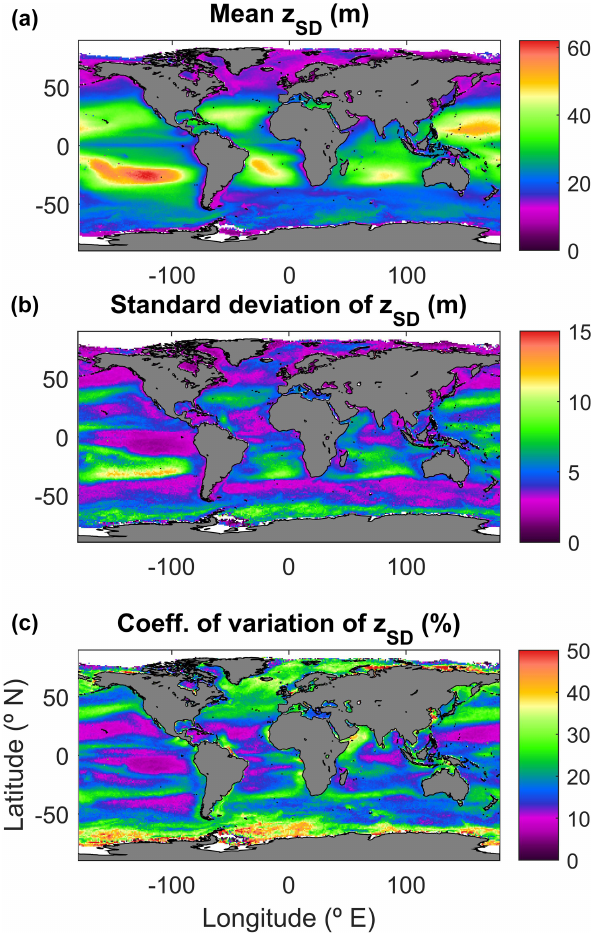
Figure 2. Global maps of the Secchi disk depth ( z SD ) in the period 1997–2018. (a) Series mean. (b) Standard deviation. (c) Coefficient of variation.